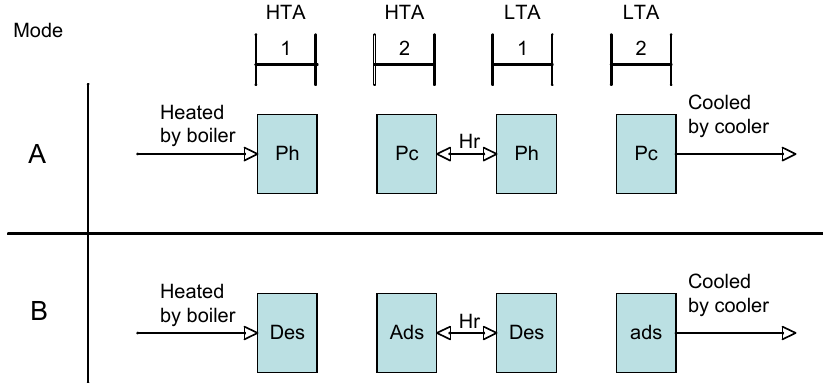
Figure 4. Schematic of the heat flow of the cascading cycle without mass recovery on the half